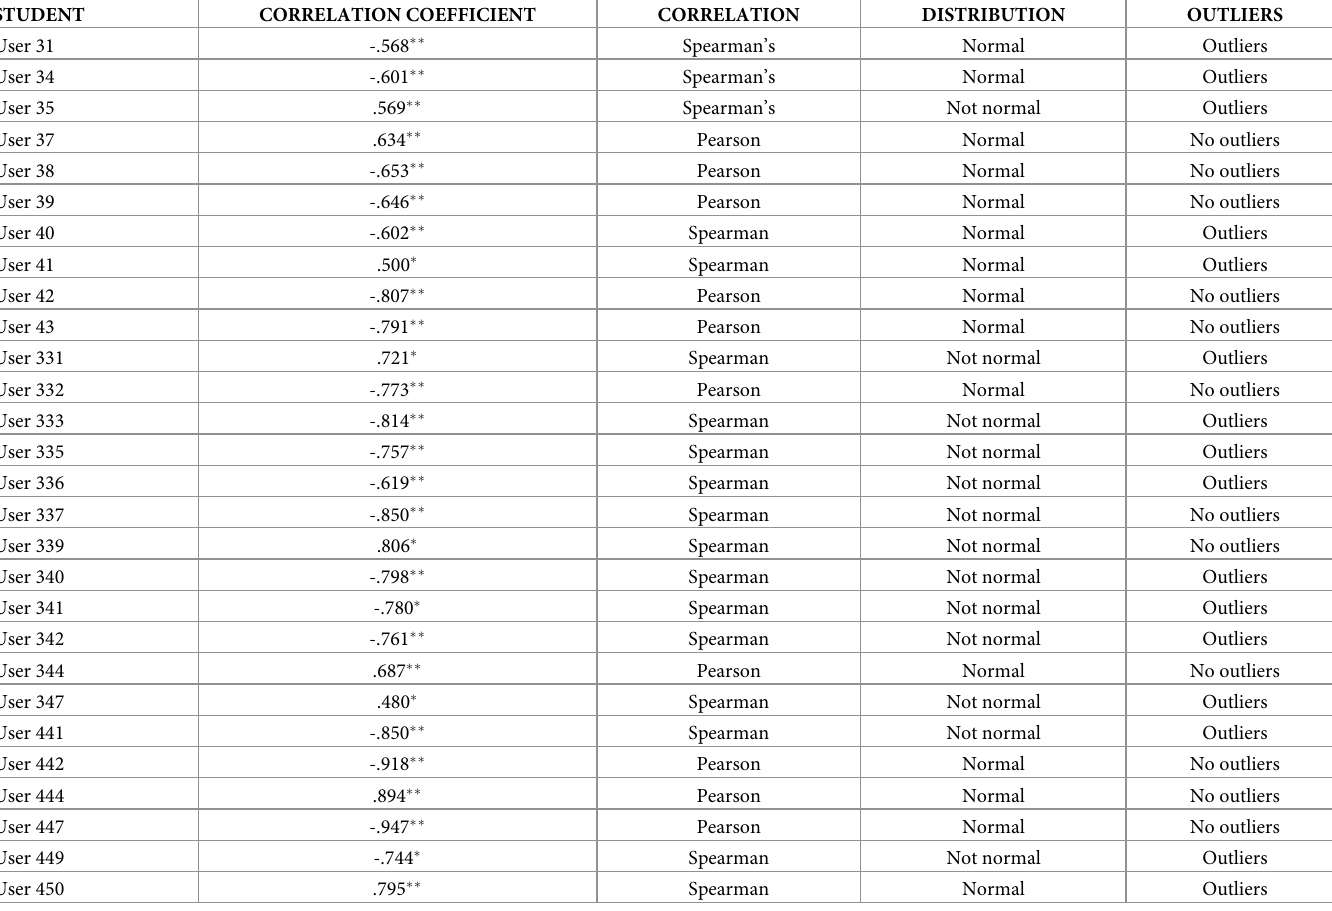
Table 1. Significant correlation coefficients between the students’ anxiety level and performance (for 28